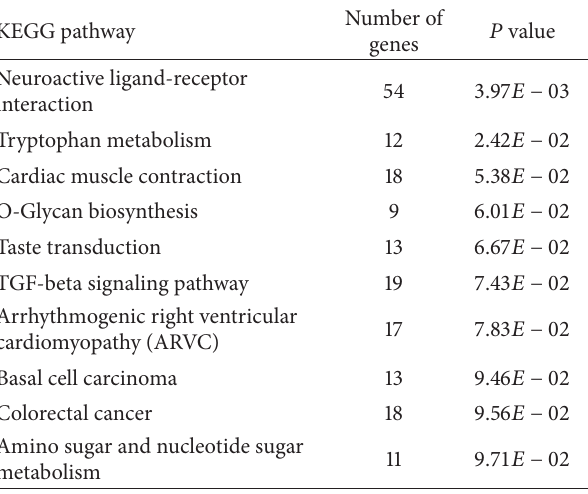
Table 3: The enriched KEGG pathway of